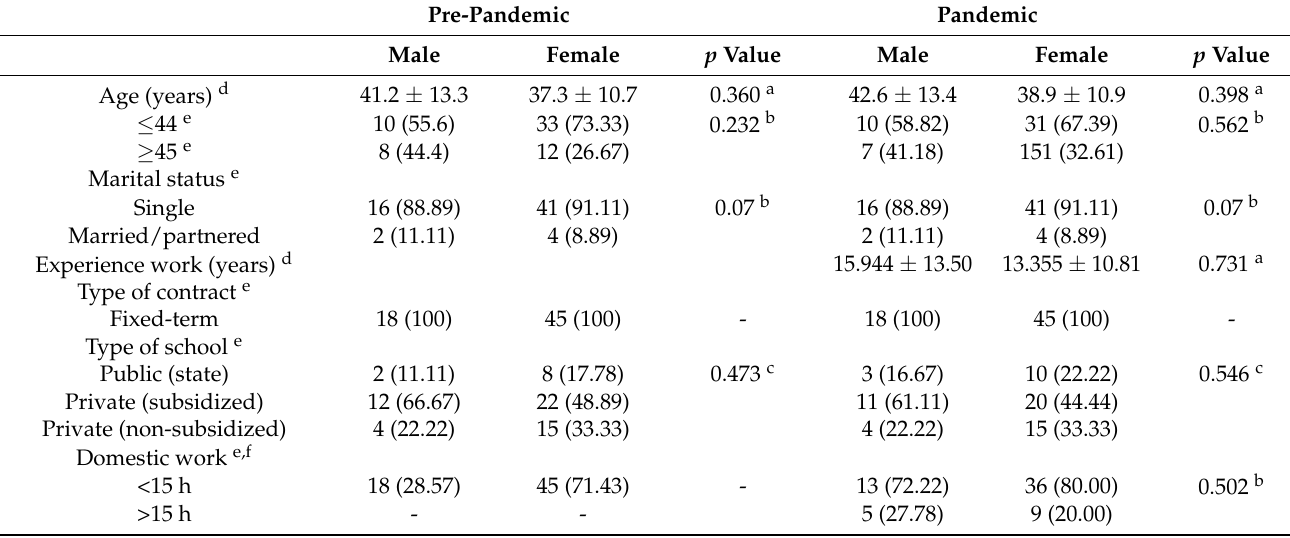
Table 1. Sociodemographic characteristics of Chilean teachers analyzed by gender before and during the COVID-19 pandemic ( n =